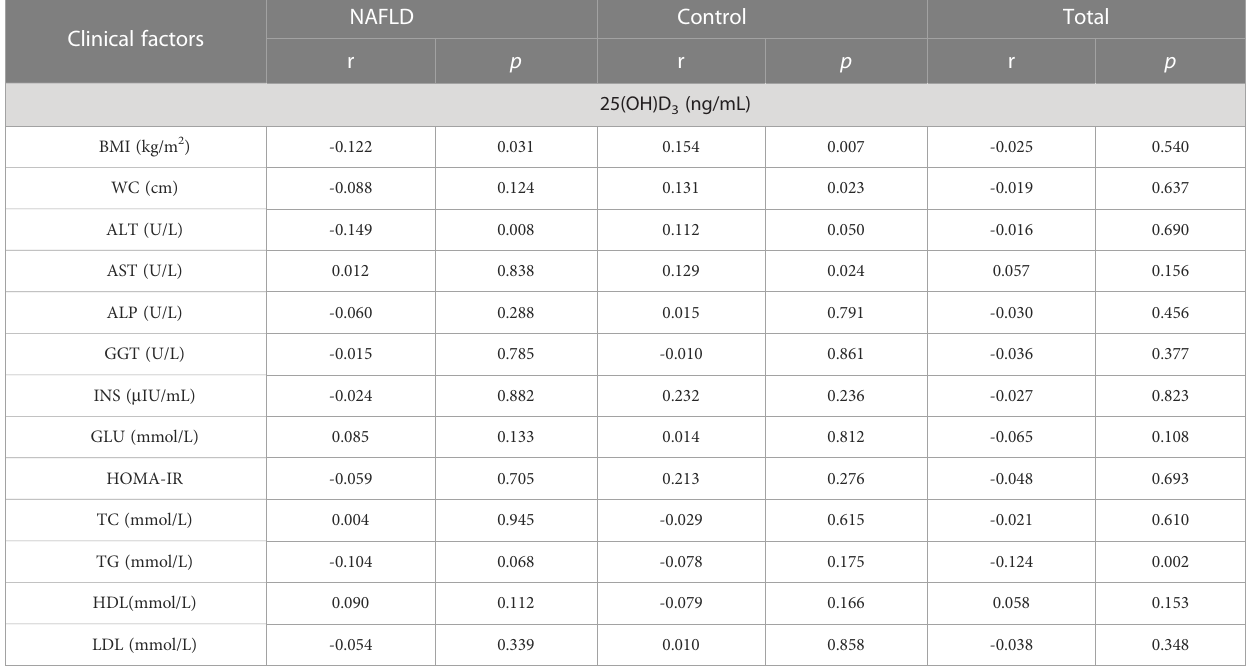
TABLE 3 Correlation of clinical factors with 25(OH)D 3 among NAFLD and controls.